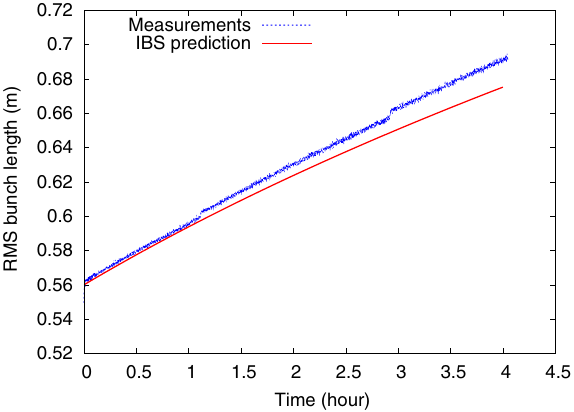
FIG. 15. Numerical modeling of bunch length growth with collision at store. Initial beam parameters similar to Fill 16697 are used.